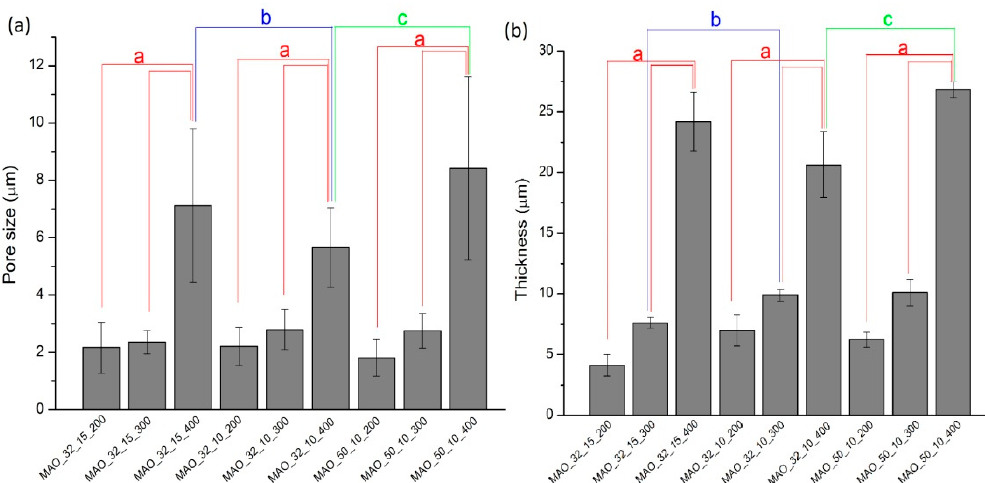
Figure 3. Pore size ( a ) and thickness ( b ) of the investigated MAO coatings with various MAO process parameters measured by ImageJ software and coating thickness guages, respectively (n = 25; data are the means ± SD; (a) significantly different in groups (p < 0.05 ) , (b) significantly different between time groups (p < 0.05 ), (c) significantly different between current groups (p < 0.05 ) ).